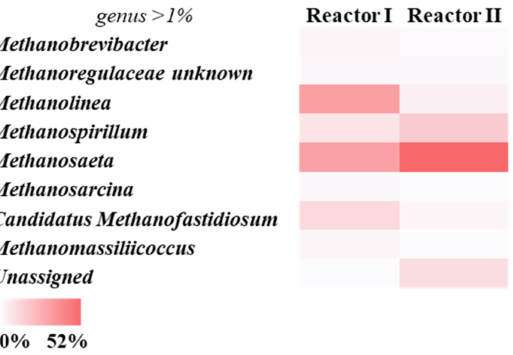
Figure 4. Frequency heat map of archaeal communities at taxonomical genera levels (only taxonomy groups having ≥ 1% of abundance in at least one sample are shown) observed in Reactor I and II. The colour intensity in each cell shows the relative ASV